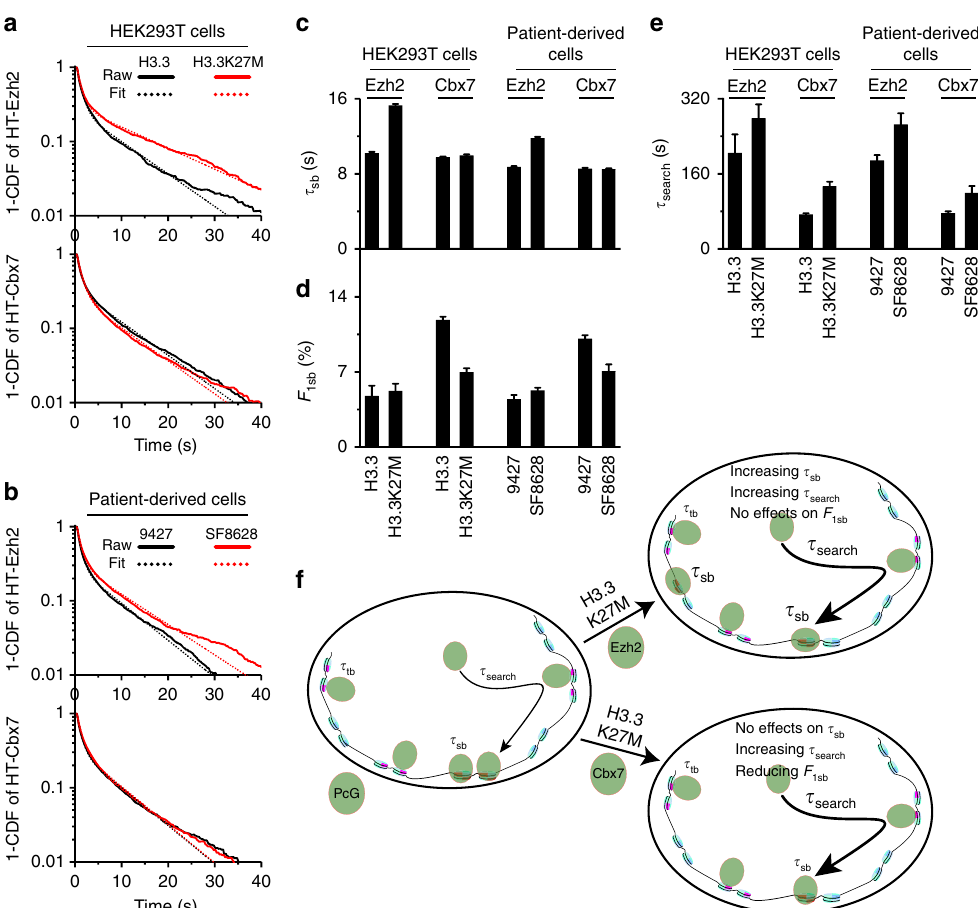
Fig. 5 The DIPG H3.3K27M mutation prolongs the search processes of Ezh2 and Cbx7, but has different effects on their stability on chromatin. a Survival probability distribution of the dwell times for HaloTag-Ezh2 in HEK293T cells expressing H3.3-FLAG ( N = 211 cells, n = 3825 trajectories) or H3.3K27M- FLAG ( N = 160 cells, n = 3137 trajectories), and for HaloTag-Cbx7 in HEK293T cells expressing H3.3-FLAG ( N = 89 cells, n = 8024 trajectories) or H3.3K27M-FLAG ( N = 45 cells, n = 6866 trajectories). The distributions were fi tted with a two-component exponential decay model. Fitted data are shown in Supplementary Table 6. b Survival probability distribution of the dwell times for HaloTag-Ezh2 in 9427 ( N = 90 cells, n = 6078 trajectories) and SF8628 ( N = 54 cells, n = 4485 trajectories) cells, and for HaloTag-Cbx7 in 9427 ( N = 110 cells, n = 4641 trajectories) and SF8628 ( N = 67 cells, n = 5376 trajectories) cells. The distributions were fi tted with a two-component exponential decay model. Fitted parameters are shown in Supplementary Table 6. c – e Residence time ( c ), fraction ( d ), and search time ( e ) of the long-lived population ( F 1sb ) for HaloTag-Ezh2 and HaloTag-Cbx7. Results are means± SD from three biological replicates. f A proposed model for the effects of H3.3K27M on the binding and search mechanisms of PcG proteins. The H3.3K27M mutation prolongs the residence time and search time of Ezh2, but has no effect on the bound level of Ezh2 (right, top panel). Given that the target search time of Ezh2 is ∼ 20-fold longer than its residence time, we propose that the reduced sampling frequency of Ezh2 for the target sites by prolonging its target search time reprograms the genomic distributions of H3K27me3 and PRC2 (right, top panel). The H3.3K27M mutation has no effect on the residence time of Cbx7 on chromatin; however, increases the target search time of Cbx7, indicating that the prolonged search time by H3K27M reduces the bound level of Cbx7 (right, bottom panel). The thicker arrowhead represents a longer search time and the bigger font depicts a prolonged residence